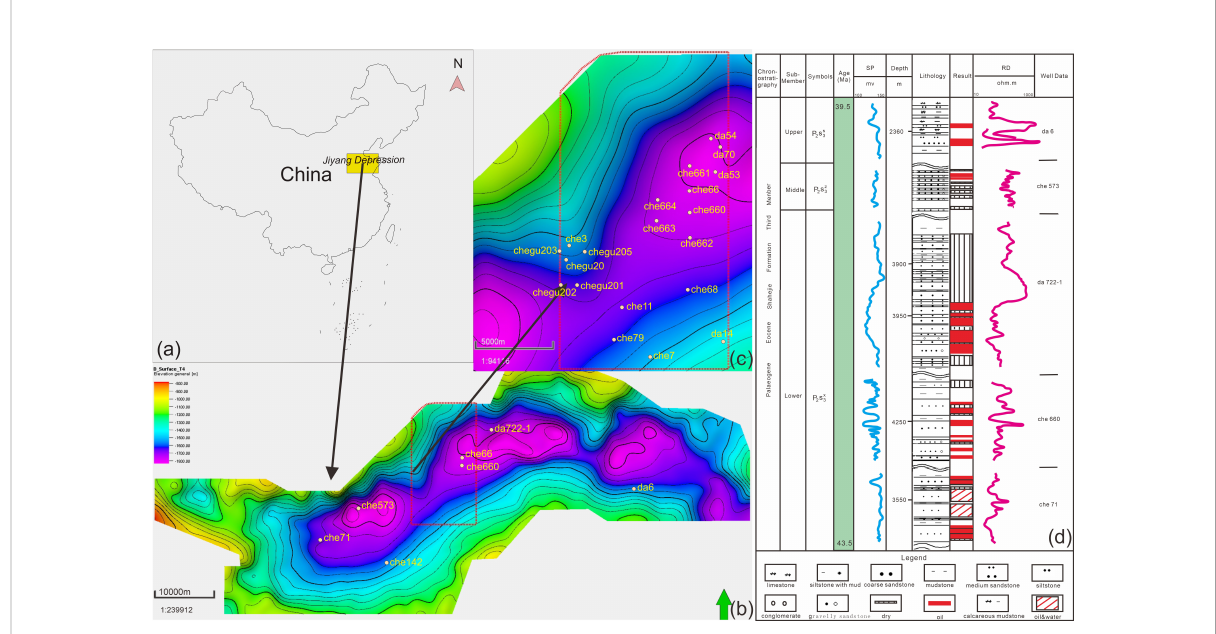
FIGURE 1 Geographic location of the study area. (A) Map of China. The yellow box is the Jiyang Depression. The Chezhen Depression is a part of the Jiyang Depression. (B) Structural map of the Chezhen Depression. The red dotted box is the location of the Taoerhe Sag. (C) Structural map of the Taoerhe Sag. There are 20 wells on the picture. (D) Stratigraphic and lithologic histogram of the third member of the Shahejie Formation in the Taoerhe